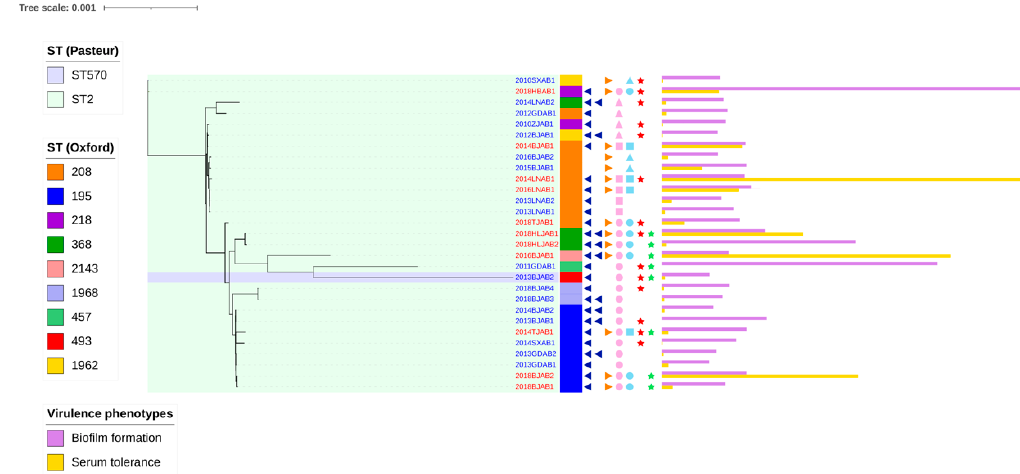
Figure 1. Phylogenetic tree of CO and SI isolates. The phylogenetic tree was constructed based on core single nucleotide variants of chromosomes. The internal colored ranges and the external colored stripes represented STs in Pasteur and Oxford typing schemes, respectively. The navy-blue left triangle and the orange right triangle indicated the location of bla OXA-23 in the chromosome and plasmid, respectively. The number of triangles indicated the number of copies of bla OXA-23 . The circle, square, and upward triangle indicated that bla OXA-23 was flanked by Tn 2006 , Tn 2009, or IS Aba1, while pink and azure classified gene location into chromosome or plasmid, respectively. The red and green stars represented minocycline and SXT resistant phenotypes. The purple and yellow bars represented the biofilm formation and serum tolerance virulence phenotypes. Table 1. Characteristics of A. baumanii that co-existed bla OXA-23 in chromosome and plasmid in our research.